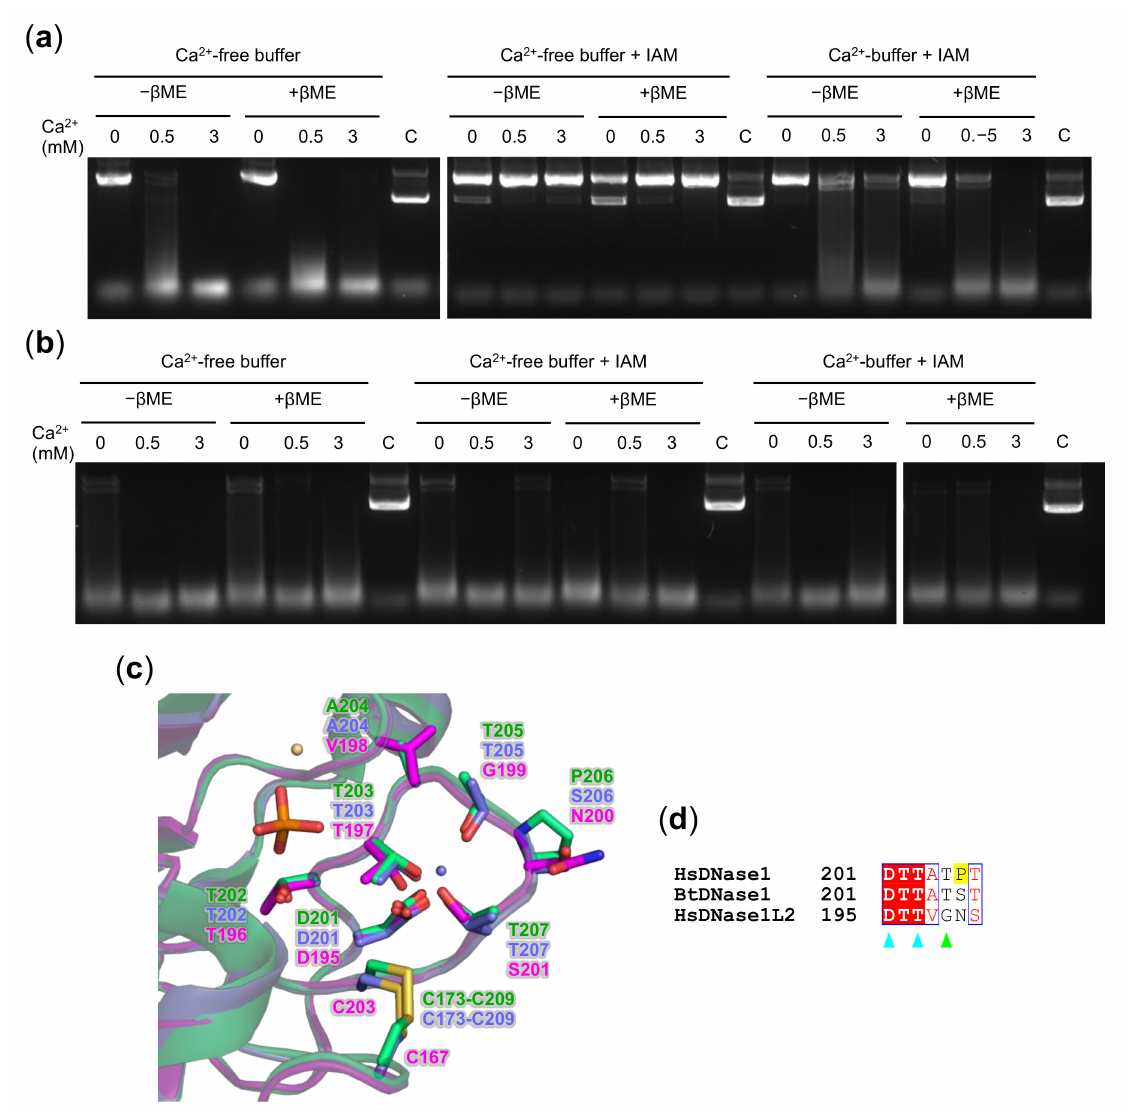
Figure 5. Ca 2+ protection of DNase1L2 reduced cysteines from alkylation. Agarose gel electrophoresis showing the effect of β –mercaptoethanol ( β ME) and iodoacetamide (IAM) on plasmid DNA digestion by ( a ) DNase1L2 and ( b ) rhDNase. The enzymes were in buffer supplemented with 1 mM CaCl 2 or in CaCl 2 -free buffer. After treatment, reactions were assembled as described in Materials and Methods. ( c ) Superimposition of the DNase1L2 model (pink carbons) with the human DNase1 structure (4AWN; green carbons) and the bovine DNase1 structure (1ATN; violet carbons), showing the calcium-binding site I. Bound Ca 2+ (violet), Mg 2+ (light orange), and phosphate (orange) ions are shown. ( d ) Aligned sequences of human DNase1 (HsDNase1), bovine DNase1 (BtDNase1), and human DNase1L2 (HsDNase1L2). The position of the first amino acid of each sequence is on the right. The residue numbering is the same as in the structure in ( c ). Key residues are indicated as follows: Ca 2+ -binding site I, cyan triangles; DNA binding, green triangle; and the proline (P206) discussed in the text is highlighted in